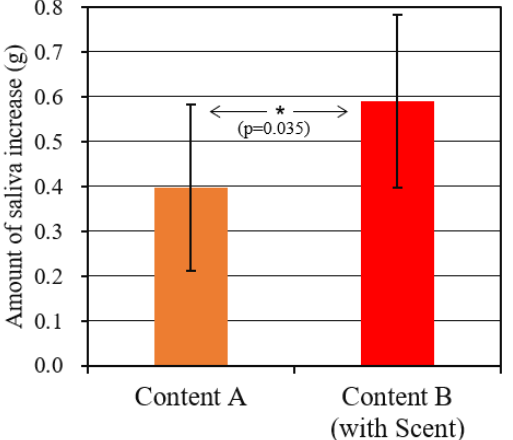
Figure 6. Increase in saliva due to dish viewing.